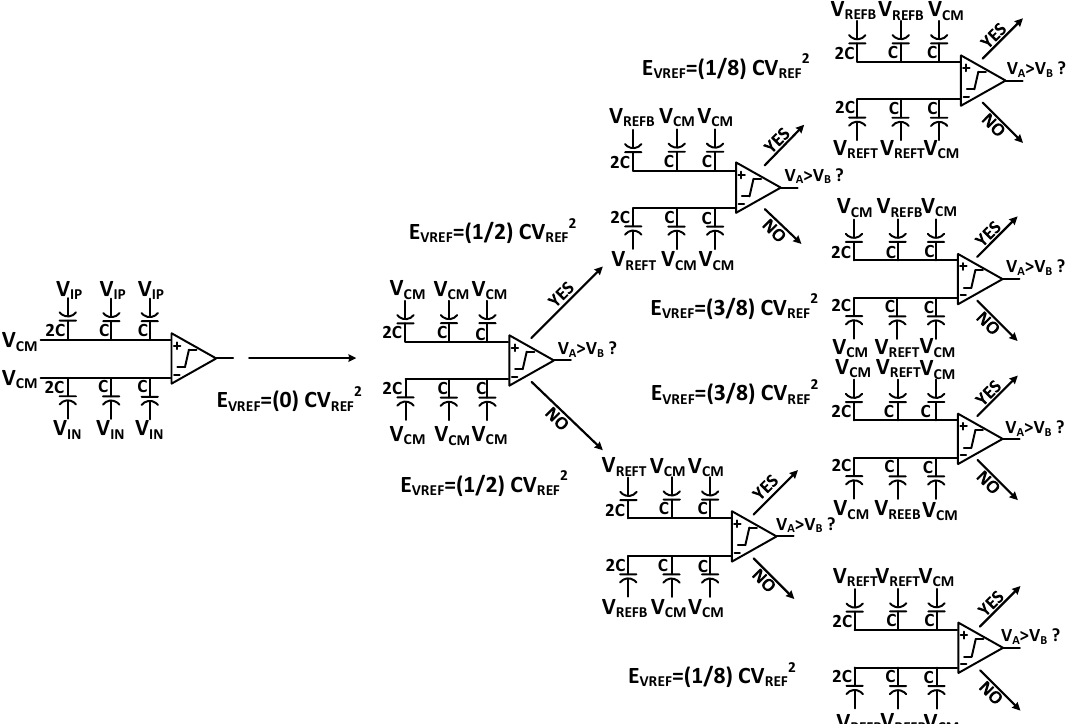
Figure 2. Switching sequence of 3-bit capacitive digital-to-analog converter (DAC).